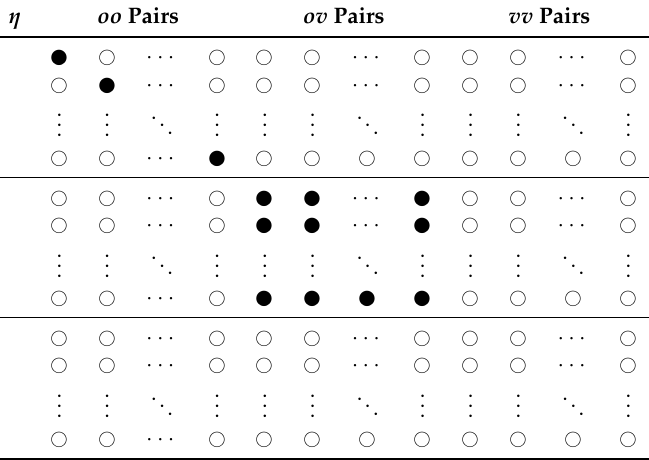
) and filled ( ) circles represent (cid:35) (cid:32)